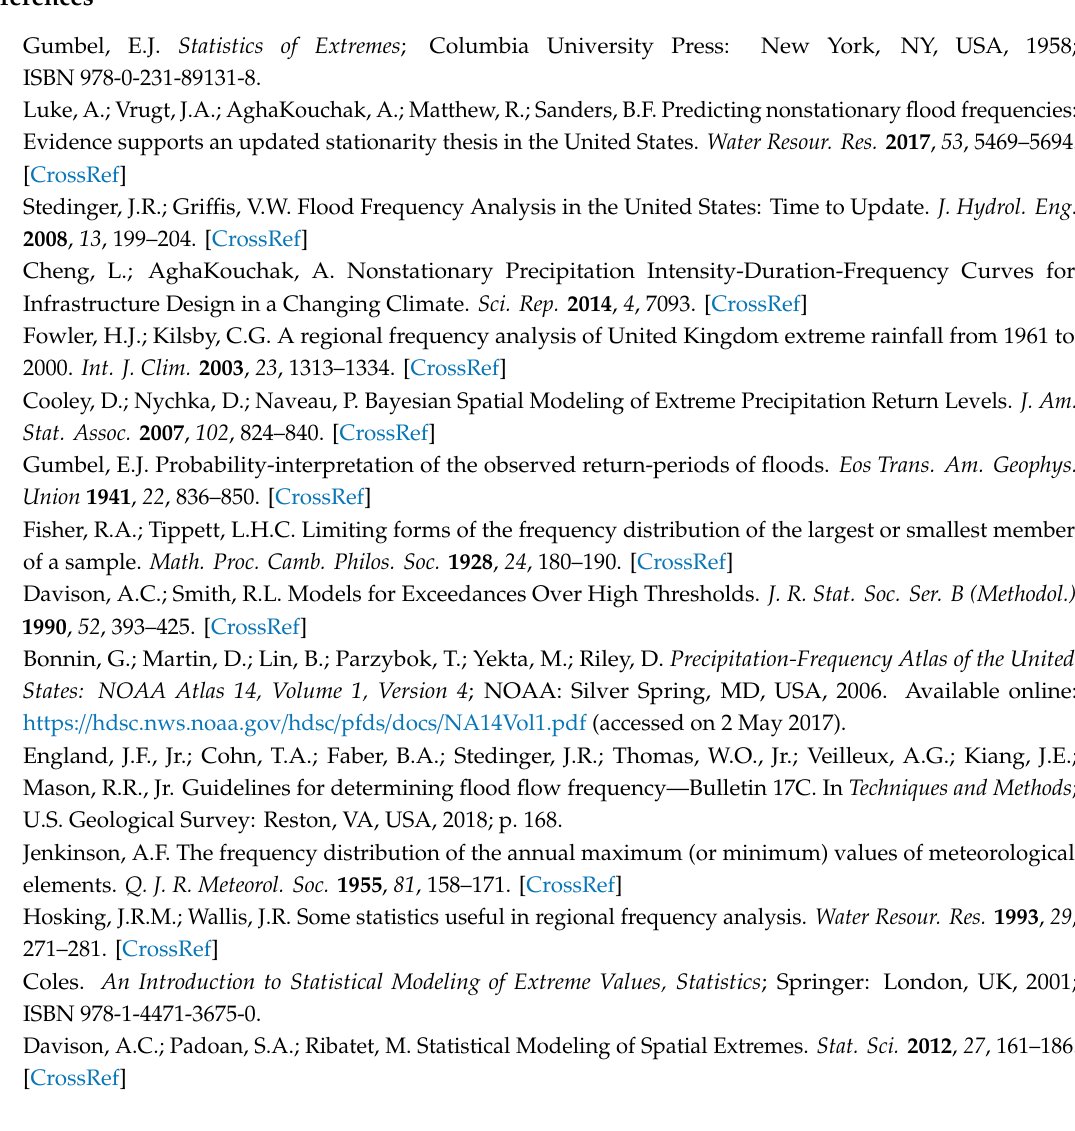
Table S1: WRB Model Performance, Table S2: EOR Model Performance, Table S3: Spatial GEV Model